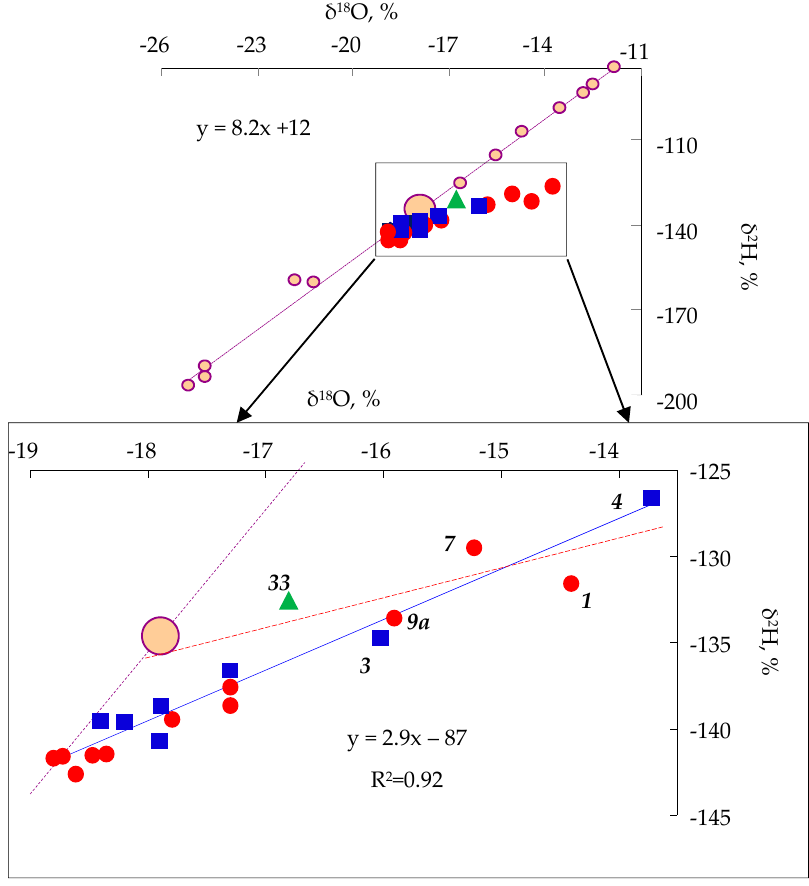
Figure 12. Stable isotopic ( δ 18 O, δ 2 H) composition of Group I (higher temperature thermal CO 2 -rich waters) (red circles), Group II (lower temperature thermal CO 2 -rich waters) (blue squares) and Group III (shallow groundwater) (green triangles) waters compared to that of modelled atmospheric precipitation (pink circles)—monthly (small symbols) and annual (large symbol) along the indicated local meteoric water line (LMWL, equation on diagram). In the magnified inset, the blue line shows the trend line through all the thermal water samples; the red line that through the groundwater and thermal waters (numbers indicate sample numbers) with the maximum shift in δ 18 O from the LMWL, the slopes of these lines being 2.9 and 1.7, respectively. The isotopic composition of precipitation was calculated using the Online Isotope in Precipitation Calculator [48].